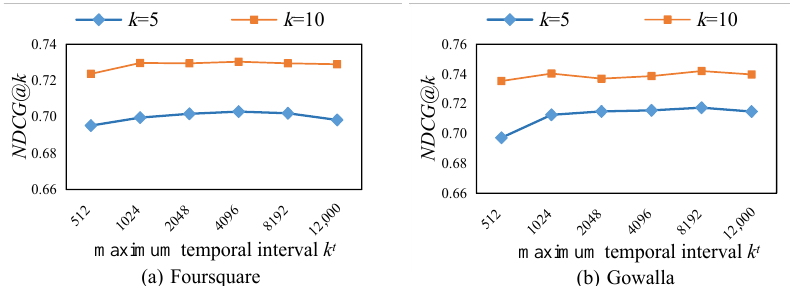
Figure 7. Effect of maximum temporal interval k t on recommendation